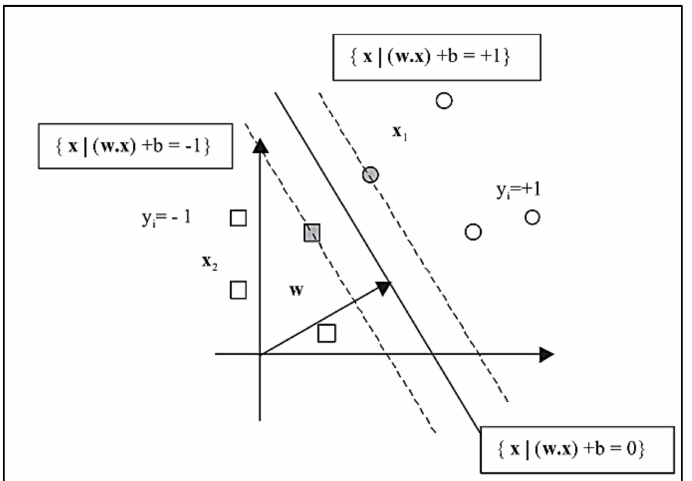
Figure 10. The classification of data with SVM. Adapted from B. Samantha